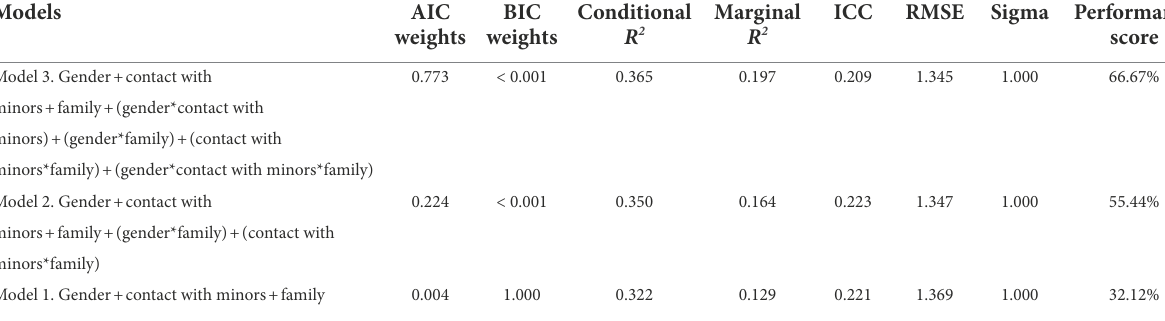
TABLE 2 Fit indexes for the tested